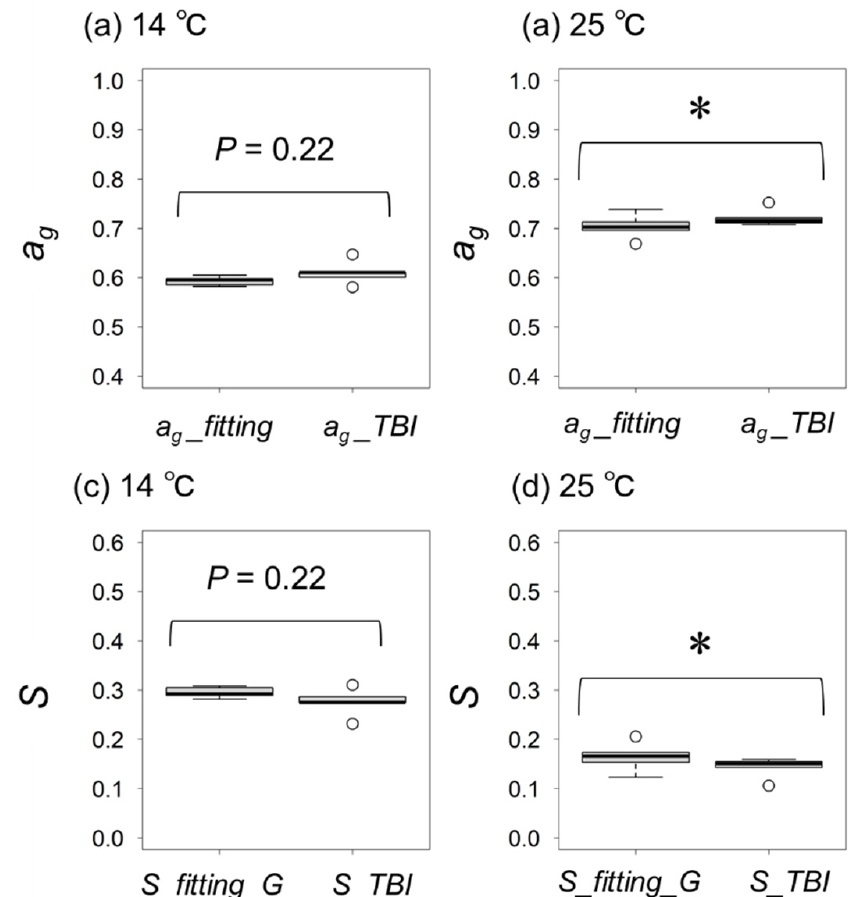
Figure 3. Comparison of the unstabilized hydrolyzable fraction of green tea ( a g ) determined by fitting an asymptote model to time series data of green tea decomposition ( a g _fitting ) and a g determined by the TBI approach ( a g _ TBI ) at ( a ) 14 ◦ C and ( b ) 25 ◦ C, and stabilization factor S of green tea determined by fitting an asymptote model to time series data of green tea decomposition ( S_fitting_G ) and S of green tea determined by the TBI approach ( S_ TBI ) at ( c ) 14 ◦ C and ( d ) 25 ◦ C. * p < 0.05. However, the second assumption was not supported in the incubation study. S_TBI was significantly smaller than S_fitting_R (Figure 4a,b), indicating that the S of rooibos